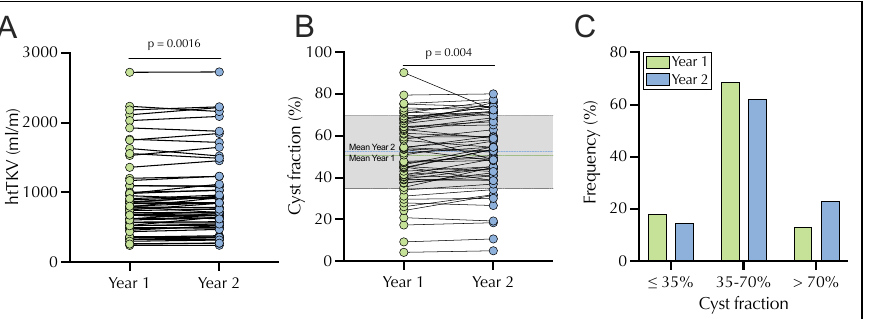
Figure 2. Longitudinal change in log htTKV ( A ) (year 1: mean 2.886 mL/m (green dotted line), year 2: 2.898 mL/m (blue dashed line)), cyst fraction ( B ) (year 1: mean 50.82% (green dotted line), year 2: 52.71% (blue dashed line)), and classification of the ADPKD cohort ( n = 61) based on cyst fraction into low (≤ 35%), medium (35–70%), and high (>70%) in year 1 and in year 2 ( C ). The grey